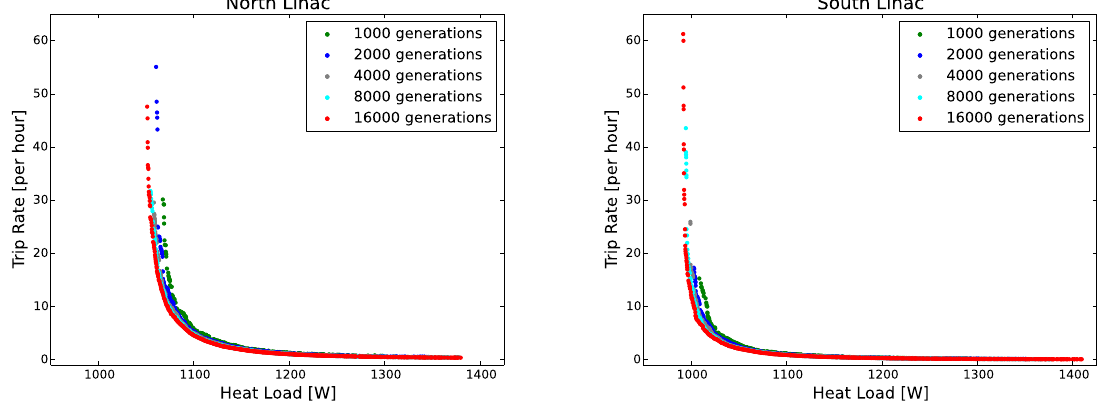
FIG. 8. Convergence of the Pareto-optimal fronts for the North (left) and South (right) linacs, as a function of the number of generations in a GA